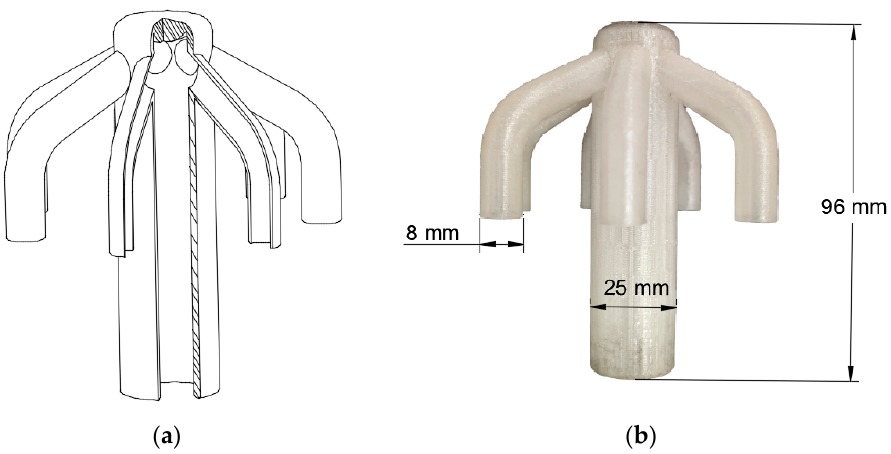
Figure 3. Seed distributor: ( a ) Schematic diagram with 1/7 removed to show the internal structure; ( b ) Real device.